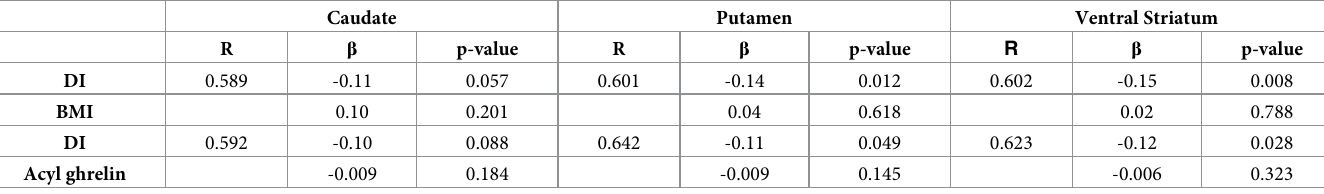
Acyl ghrelin -0.009